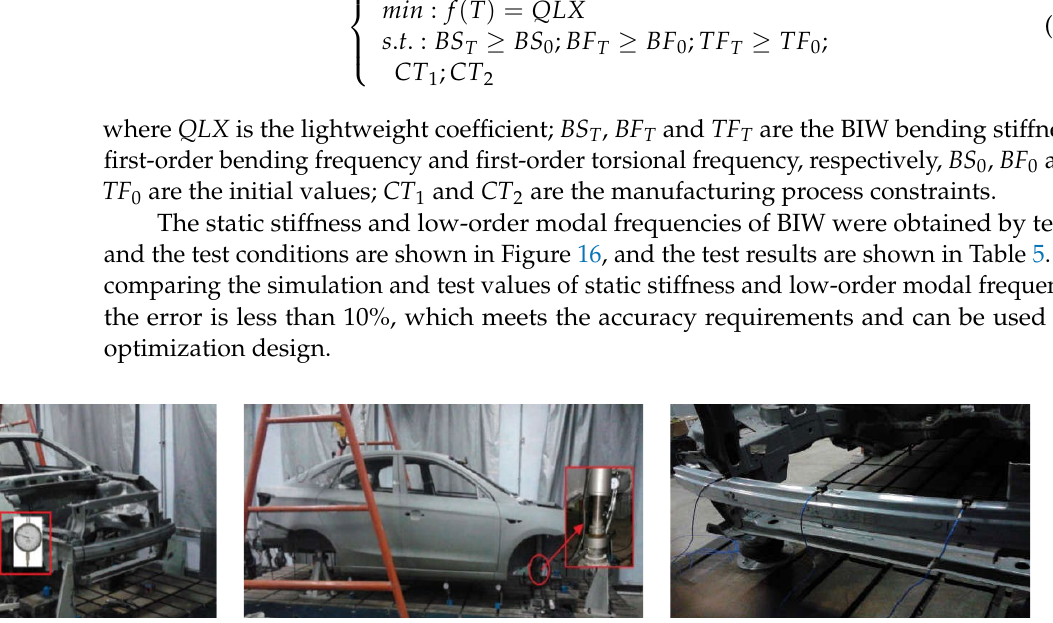
Figure 15. Schematic diagram of super layer analysis.